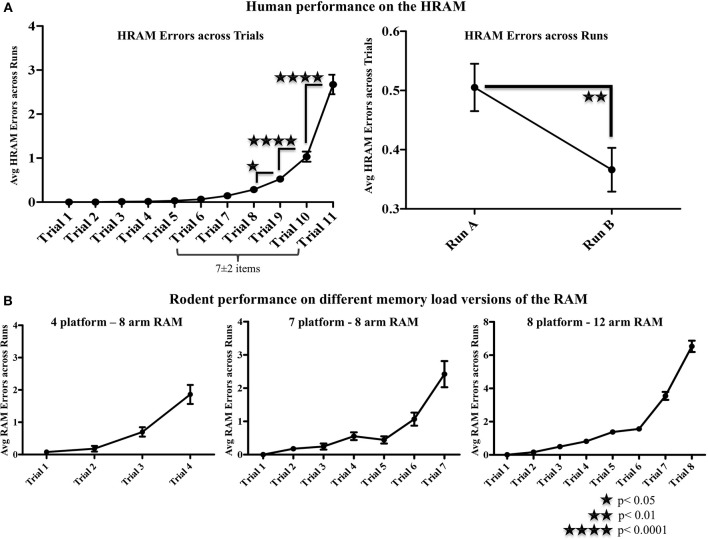
Human and rodent radial arm maze performance. (A) There was a significant main effect of Trial [F(10, 1520) = 97.19; p < 0.0001] on HRAM Errors, with HRAM Errors increasing as trials progressed and working memory load increased. HRAM Errors increased from trial 8 to 9 (Trial 8: M = 0.28, SE = 0.04; Trial 9: M = 0.53, SE = 0.06; p < 0.05), from trial 9 to trial 10 (Trial 10: M = 1.03; p < 0.0001) and again from trial 10 to trial 11 (Trial 11: M = 2.67, SE = 0.11; p < 0.0001). HRAM Errors declined significantly across Testing Sessions [Both Sessions: M = 0.436, SE = 0.04, Session 1: M = 0.51, SE = 0.04, Session 2: M = 0.37, SE = 0.04; F(1, 152) = 7.85; p < 0.01]. (B) Similar patterns of performance are seen in the 7/8 arm (unpublished observations from the Bimonte-Nelson lab), 4/8 arm (see also: Camp et al., 2012), and 8/12 arm (see also: Bimonte-Nelson et al., 2003) versions of the rodent water RAM.